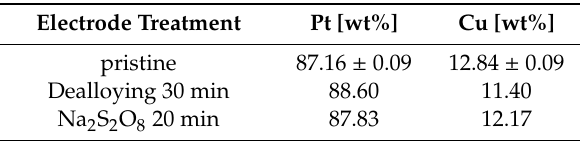
Table 1. XRF Measurement of three pristine platinum electrodes with electrodeposited platinum-copper alloy. Two of these electrodes where treated with di ff erent etching methods for copper (electrochemical dealloying and wet chemical etching).